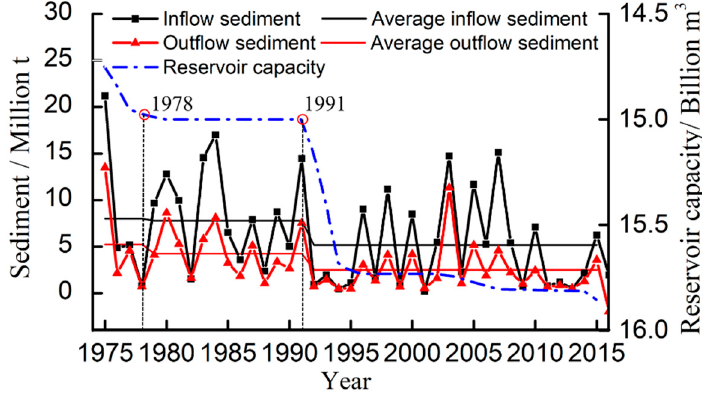
Figure 11. The relationship between sediment flowing into and out of Hongze Lake and the total volume of the upstream reservoir.